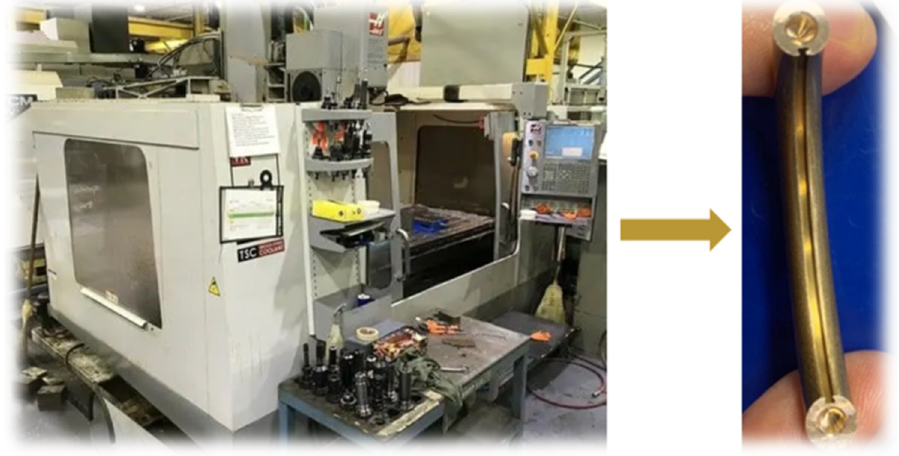
Figure 5. CNC machine and its machined piece—reference “ring”.